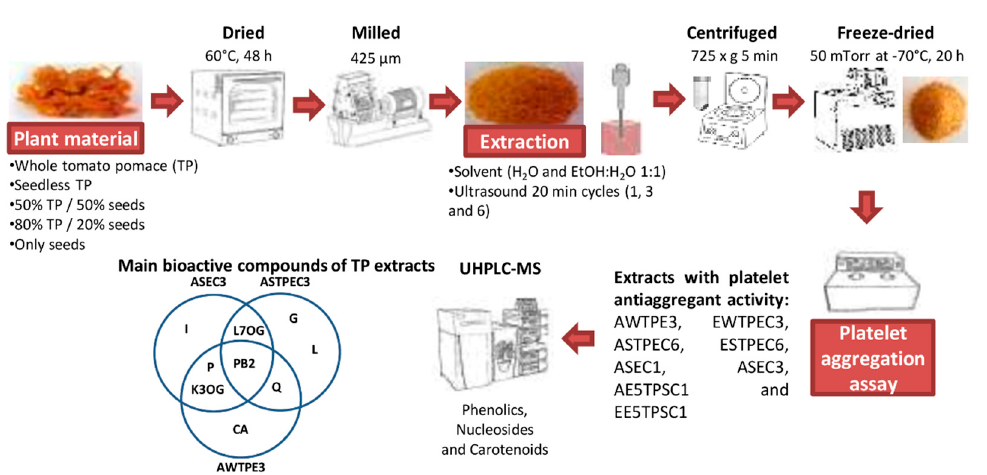
Figure 2. Platelet anti-aggregant activity and bioactive compounds of ultrasound-assisted extracts from whole and seedless tomato pomace. AE5TPSC1: aqueous extract 50% tomato pomace/50% seed